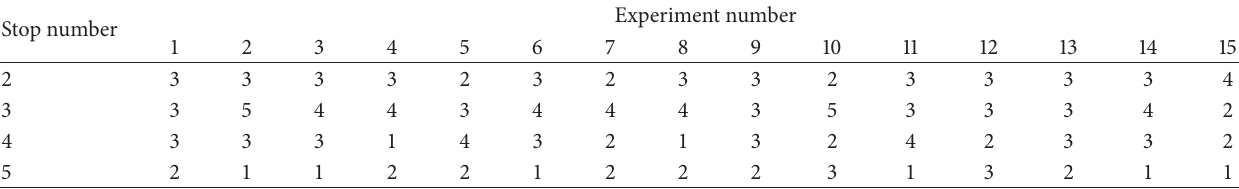
Table 4: Information on the number of outgoing